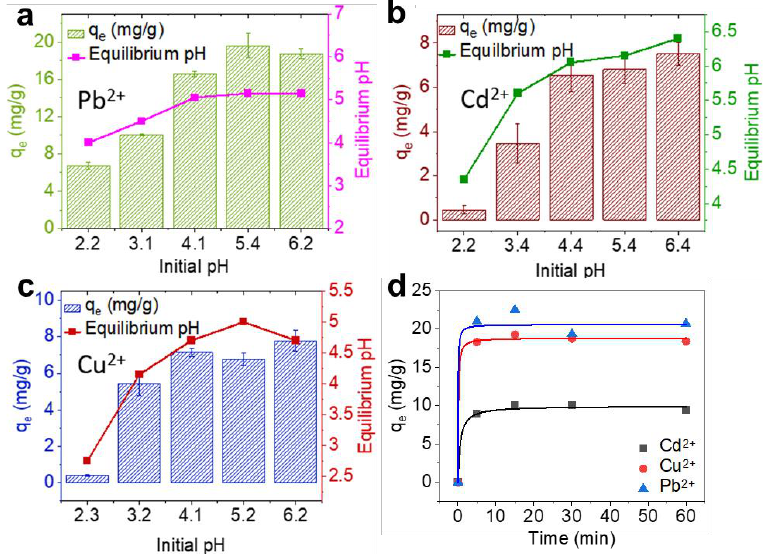
Figure 4. ( a – c ) pH dependence on ( a ) Pb 2+ , ( b ) Cd 2+ and ( c ) Cu 2+ uptake by ZVI-L1000 (initial concentration 100 ppm, solution volume 25 mL, 25 °C, 15 min); ( d ) Pseudo-second-order kinetic fittings for Cu 2+ , Pb 2+ and Cd 2+ uptake by ZVI-L1000 (initial concentration 100 ppm, solution volume 25 mL, 25 °C, pH values 6.4 (Cd 2+ ), 6.2 (Cu 2+ ) and 5.4 (Pb 2+ )).